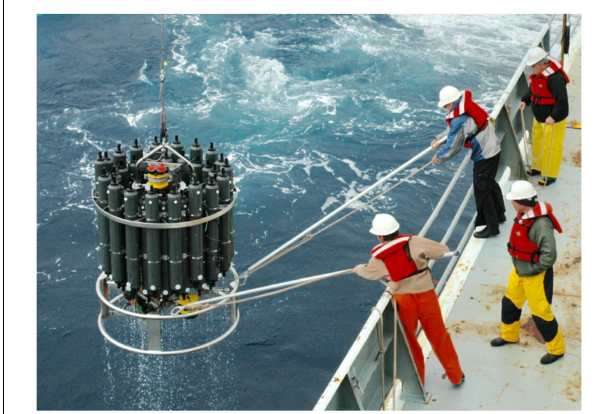
FIGURE 1 | A rosette sampler with Niskin bottles. The conductivity, temperature, depth (CTD) sonde is inside of the ring near the bottom (not visible) (Photo credit: Sabine Mecking, University of